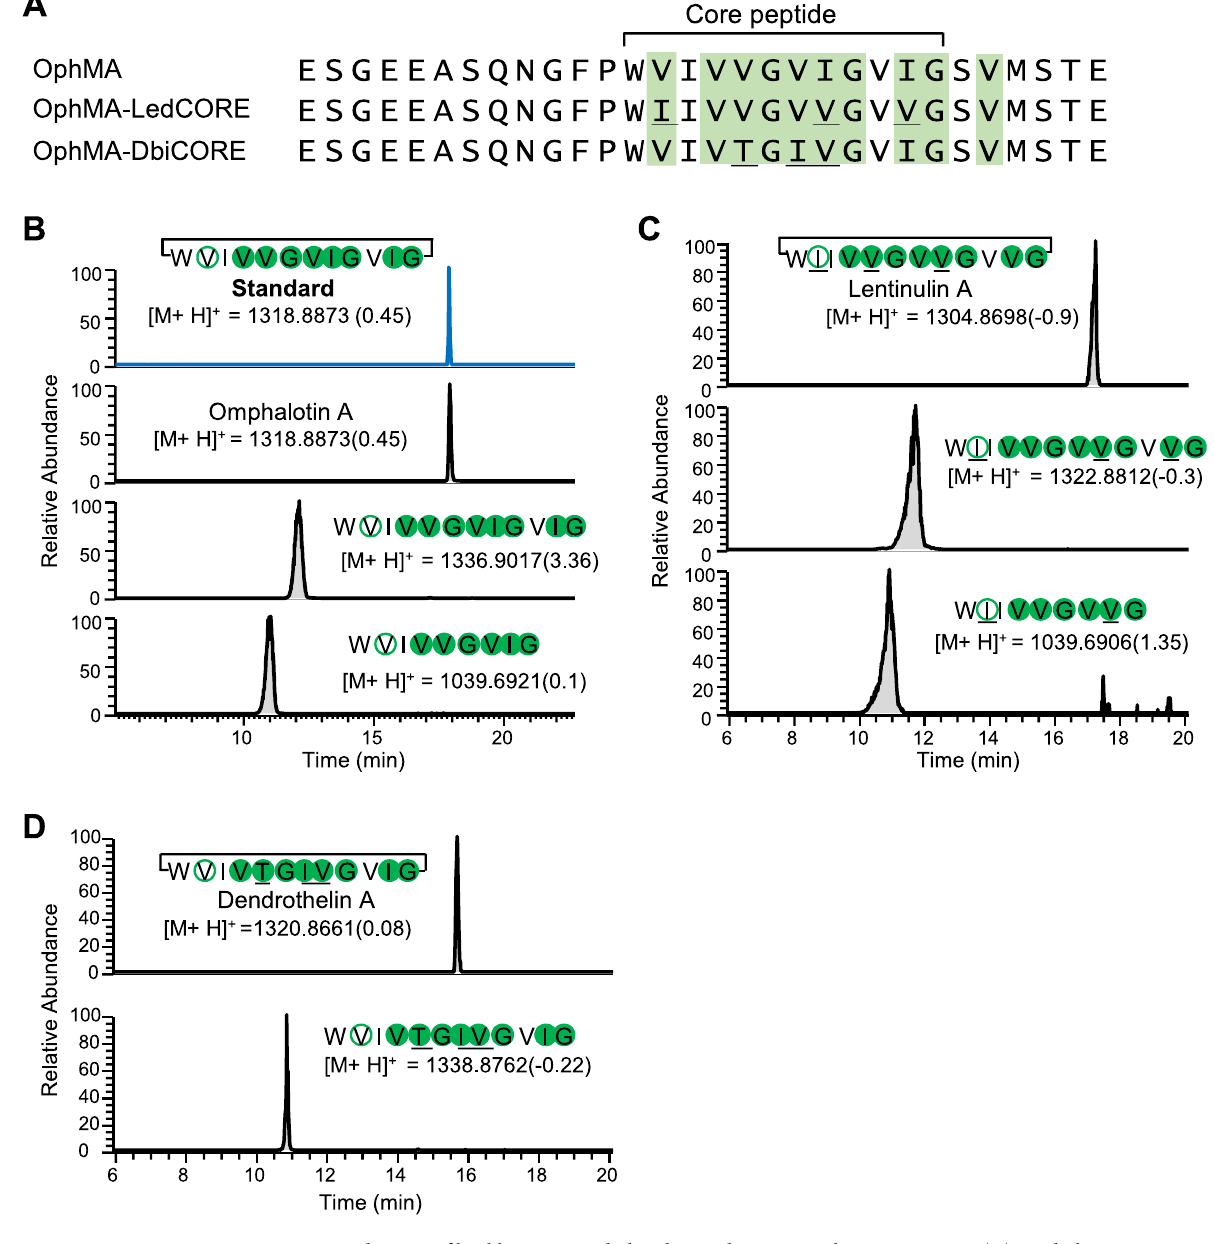
Figure 2. Production of backbone N-methylated peptide macrocycles in P. pastoris . ( A ) Methylation pattern of OphMA, OphMA_LedCORE and OphMA_DbiCORE. Methylated residues were determined by LC–MS/ MS analysis of the C-terminal tryptic fragments and are shaded in green (Supplementary Fig. S2A–C). ( B ) Production of omphalotin A. The extracted compound was detected using LC–MS and compared to the chemically synthesized omphalotin A standard (216 ng/ml). In addition to omphalotin A, fully methylated, linear (core) peptides and short linear peptides lacking the C-terminal three residues (VIG) were detected. ( C ) Production of lentinulin A and ( D ) dendrothelin A. The detected peptides were confirmed by LC–MS/MS. The confirmed positions of methylation are depicted using filled circles, while methylated residues inferred from MS/MS are shown in open circles. Residues different from omphalotin A are underlined. The mass difference (represented in ppm) between observed values and theoretical mass is indicated in brackets for each